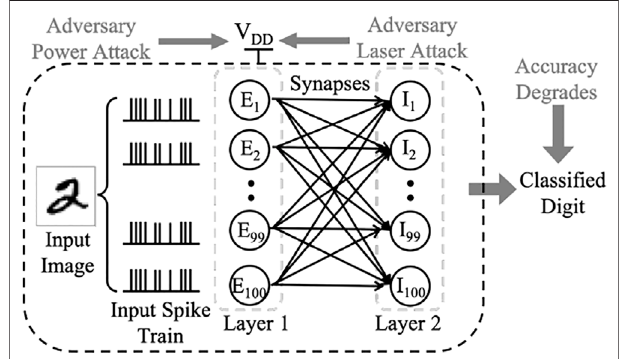
FIGURE 1 | Threat model for power-based attacks on